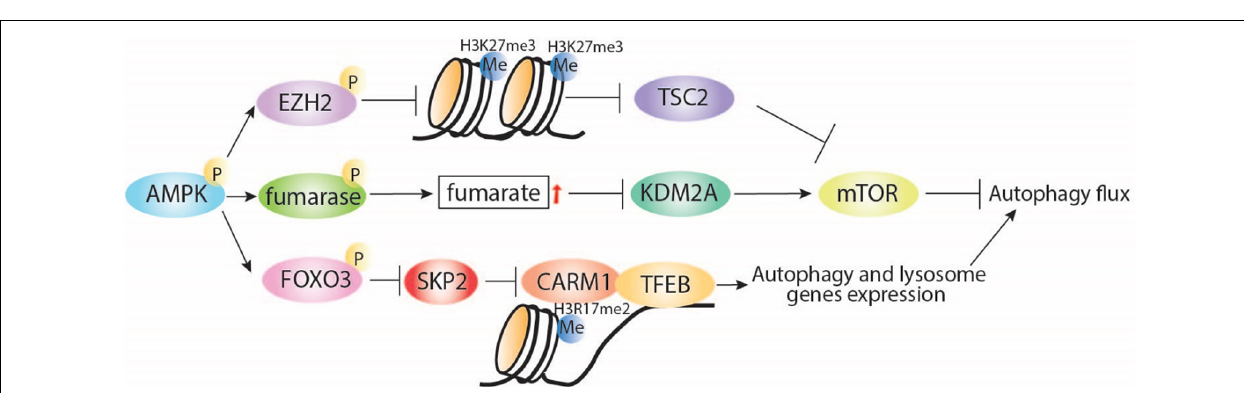
FIGURE 2 | AMPK regulates autophagy through interaction with regulators of histone. AMPK inhibits H3K27me3 via direct phosphorylation of EZH2, which was reported to release TSC2 expression and then induce autophagy via inhibition of mTORC1. Under starvation conditions, AMPK can indirectly increase fumarate levels, leading to KDM2A repression, mTOR inhibition, and induction of autophagy. In addition, starvation-induced AMPK can regulate histone methylation through induction of autophagy via FOXO3 phosphorylation, transcriptional repression of SKP2, and nuclear translocation of CARM1, which directly interacts with